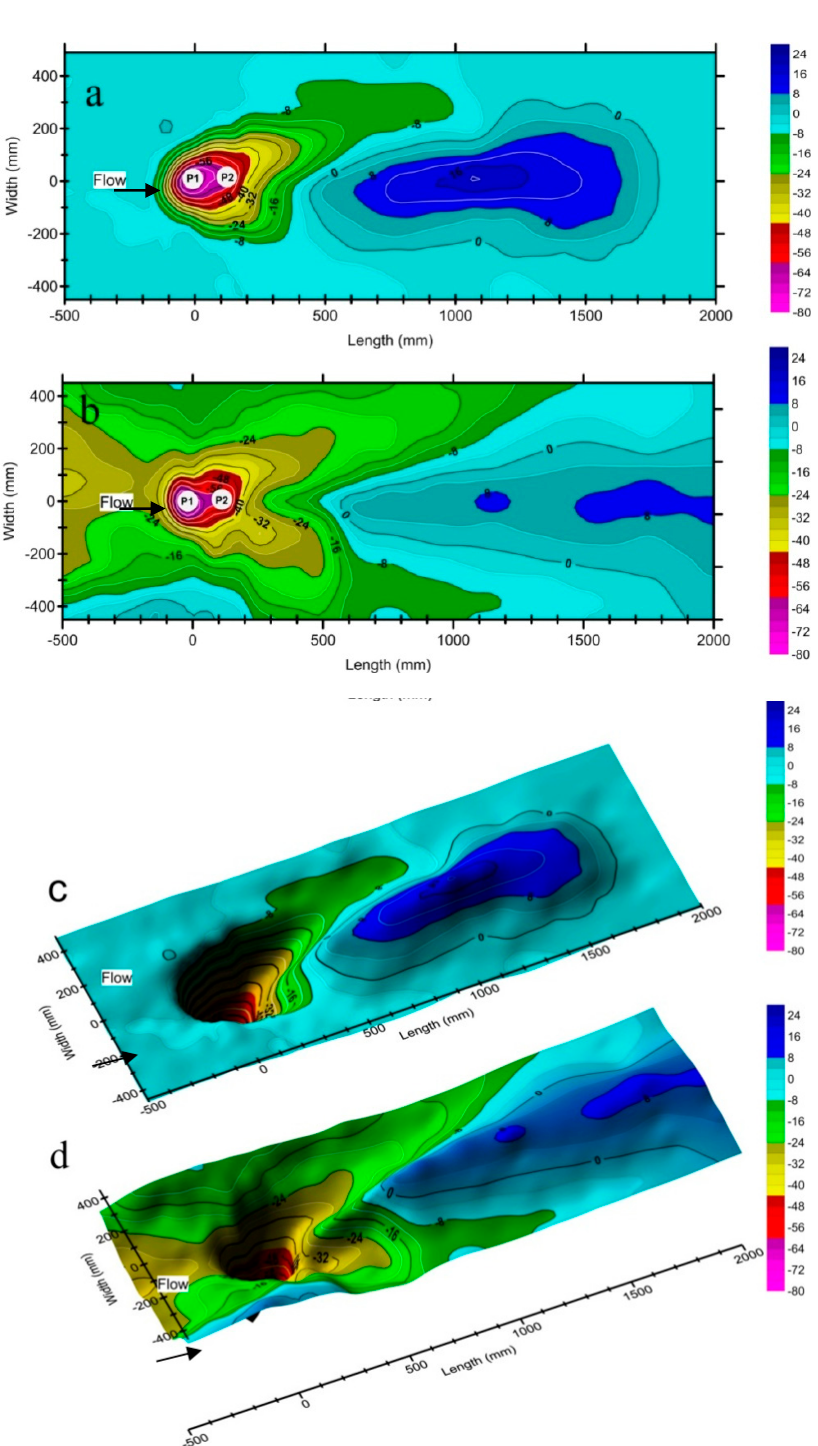
Figure 8. Contour plan of streambed morphology around the piers for ( a ) no pit and ( b ) with pit cases, as well as the perspective plots for ( c ) no pit and ( d ) with pit cases.